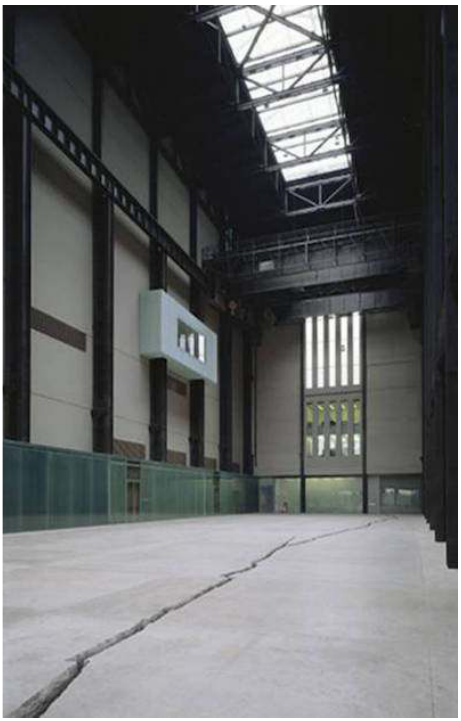
Figure 3: Doris Salcedo, Shibboleth I , 2007. Tate